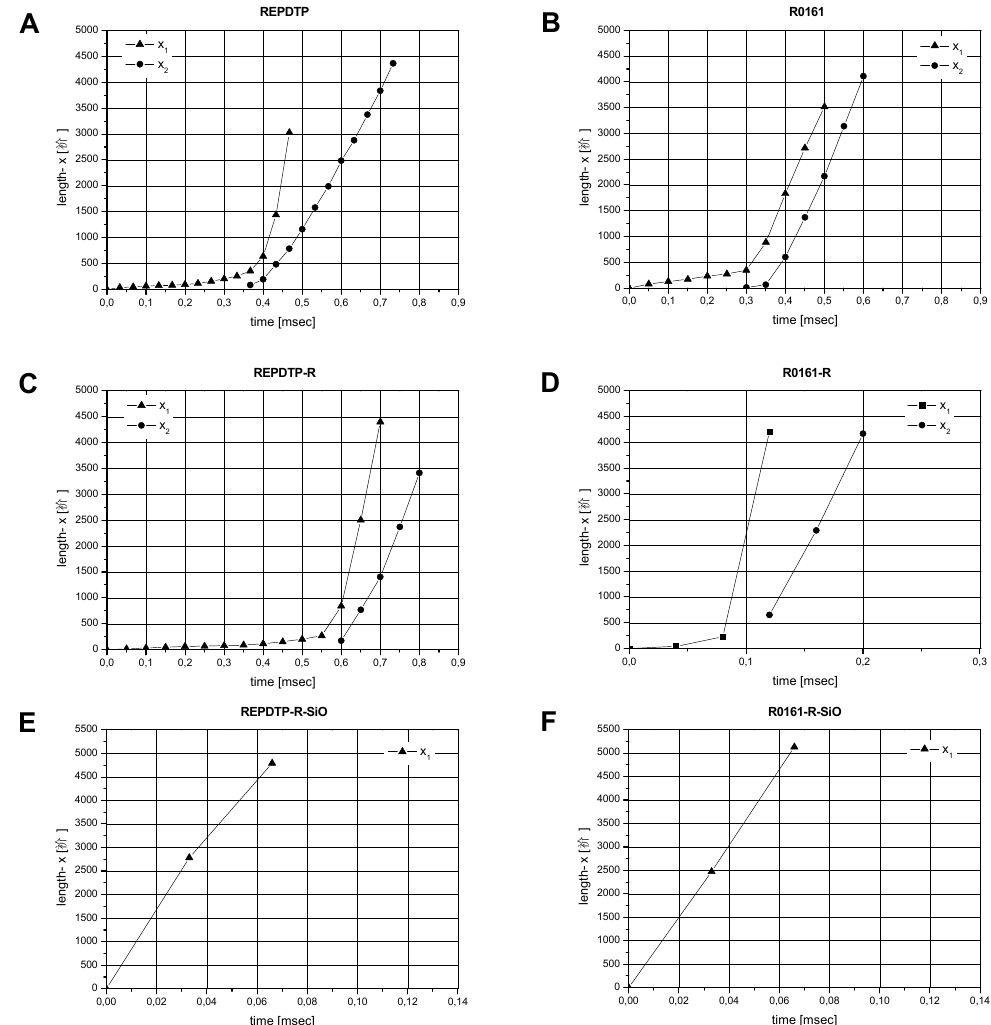
Figure 13. Drop dynamics (positions x1 and x2 of the beginning and end of the primary drop/primary thread) as a function of time for materials of category I ( A – D ) and materials of category III in plots ( E , F ).